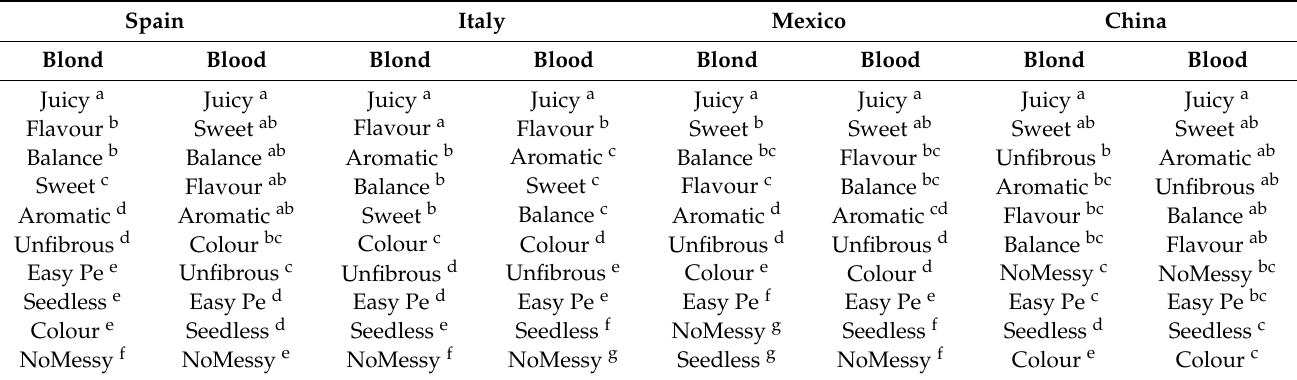
Table 4. Ranking of sensory attributes’ importance for consumer satisfaction after eating blond/blood oranges. Importance was scored in a 7-point scale (1—not important at all, 7—very important) by Spanish, Italian, Mexican and Chinese consumers ( n = 605 in each